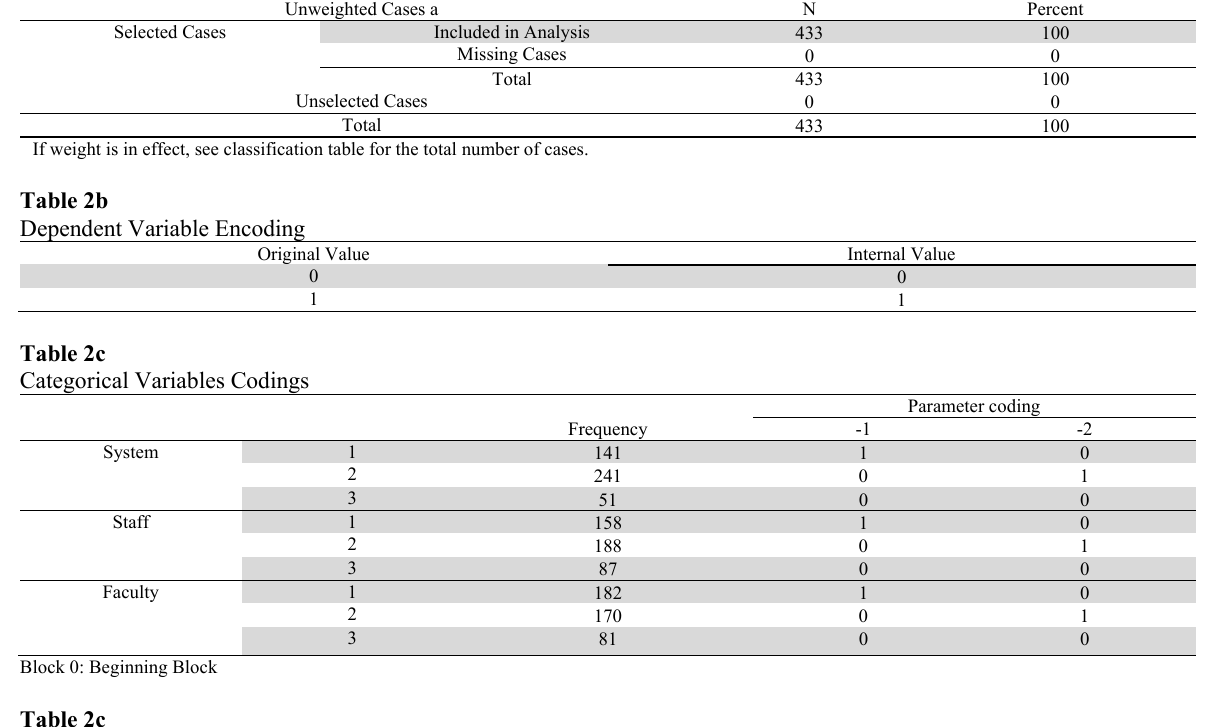
Case Processing Summary